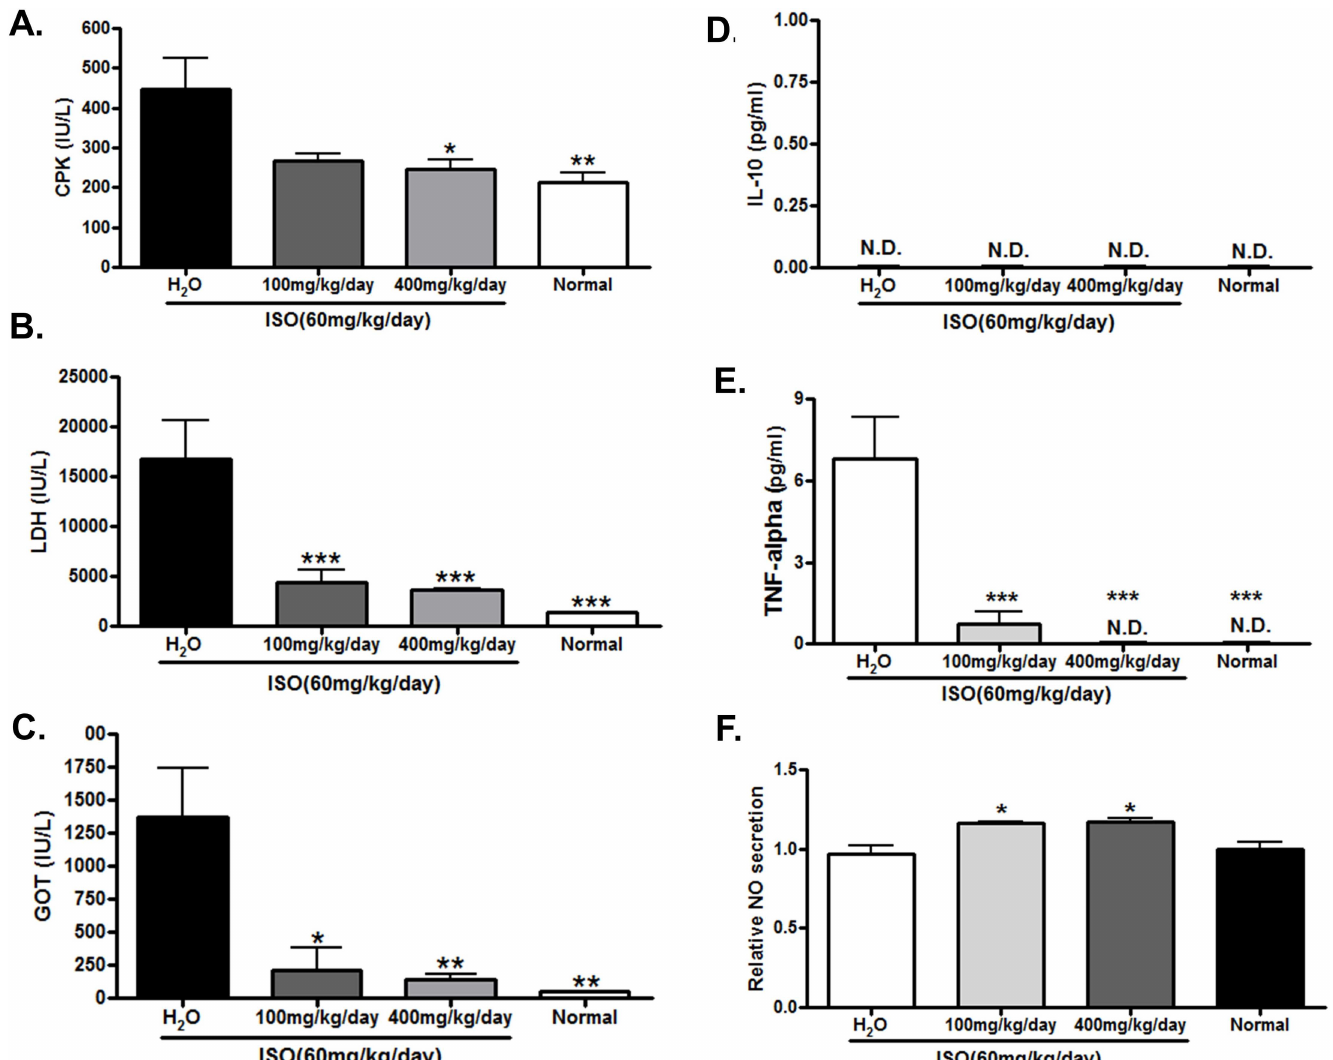
Fig 4. DRLE prevented ISO-induced elevation of CPK, LDH, GOT, and TNF- α , and elevated serum NO level. Serum levels of biomarkers and cytokines in normal and ISO-induced mice treated with H 2 O, 100 and 400 mg/kg/d DRLE. (A) CPK (B) LDH (C) GOT. (D) IL-10 (E) TNF- α (F) NO. * , P < 0.05 vs. H 2 O; ** , P < 0.01 vs. H 2 O; *** , P < 0.001 vs. H 2 O (n = 3 to 5 per